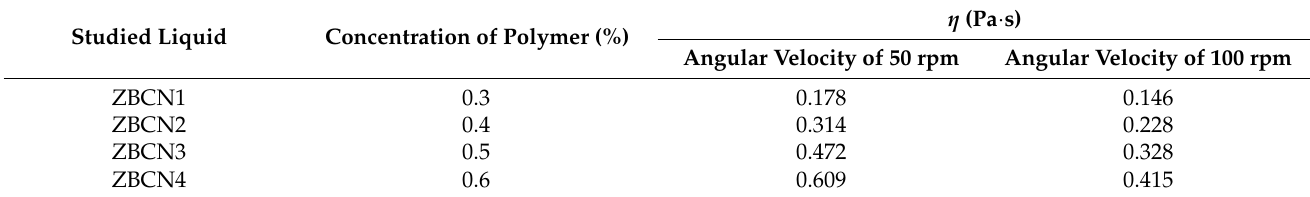
Table 1. The obtained test results and operation